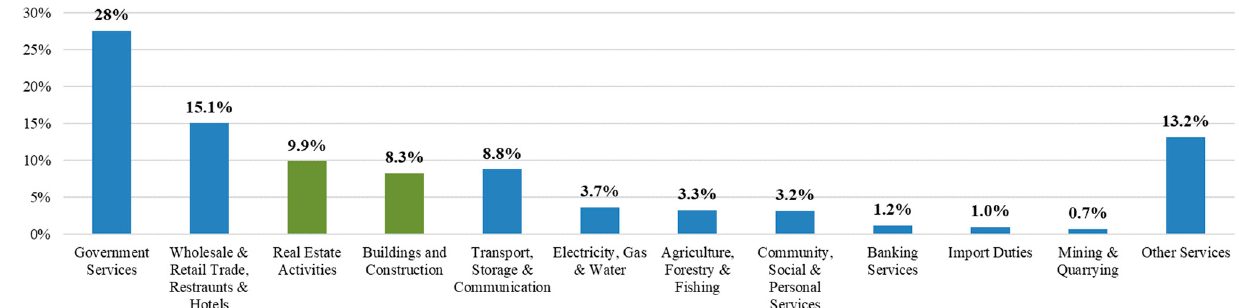
Figure 1. Contribution to Real Estate Activities and Construction in Saudi Arabia (shown in green).